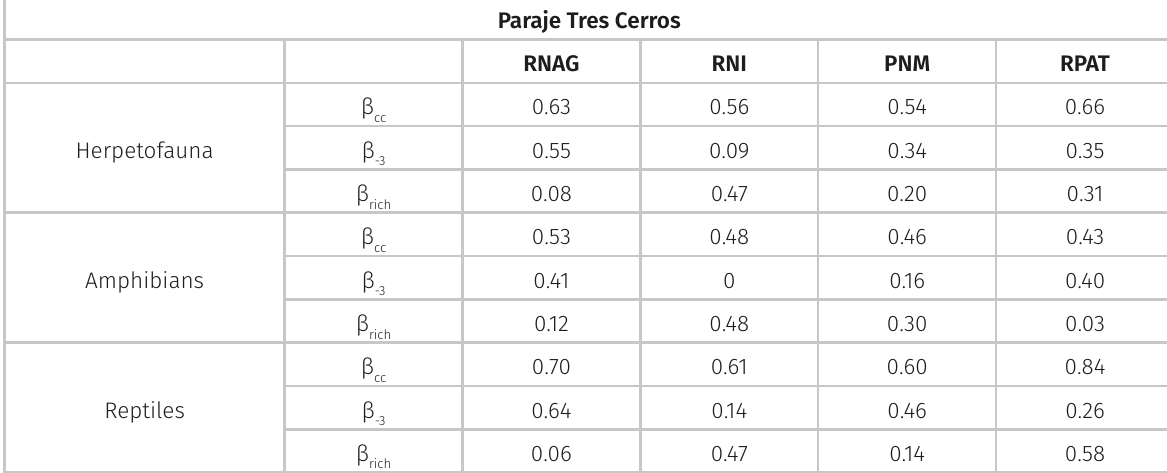
) species replacement (β ), and species richness difference (β cc , -3